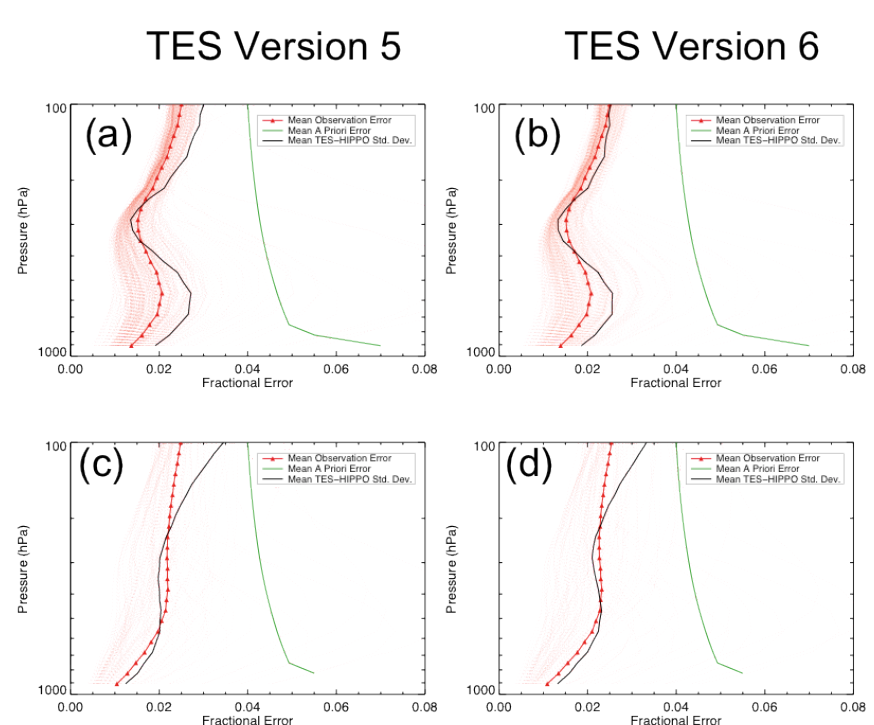
Figure 7. Theoretical observations errors for each TES CH 4 retrieval (dotted red lines) and the mean theoretical error (solid red line and triangles) versus pressure, along with the mean a priori error estimate (green line) and the standard deviation of the TES-HIPPO differences. (a) and (c) are the TES Version 5 CH 4 retrievals with DOFS ≥ 1.6 and DOFS < 1.6, respectively. (b) and (d) are the TES Version 6 CH 4 retrievals with DOFS ≥ 1.6 and DOFS < 1.6,